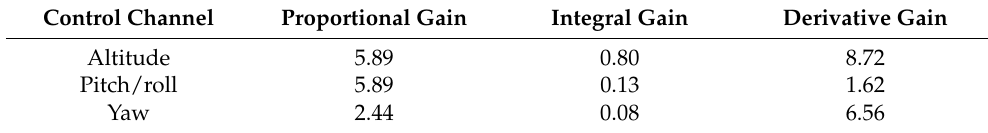
Figure 3. Simulation model architecture. MPC outputs and inputs into plant model are separated to allow for decoupled control action. Table 3. PID gains of the different inner-loop controller for the quadrotor simulation